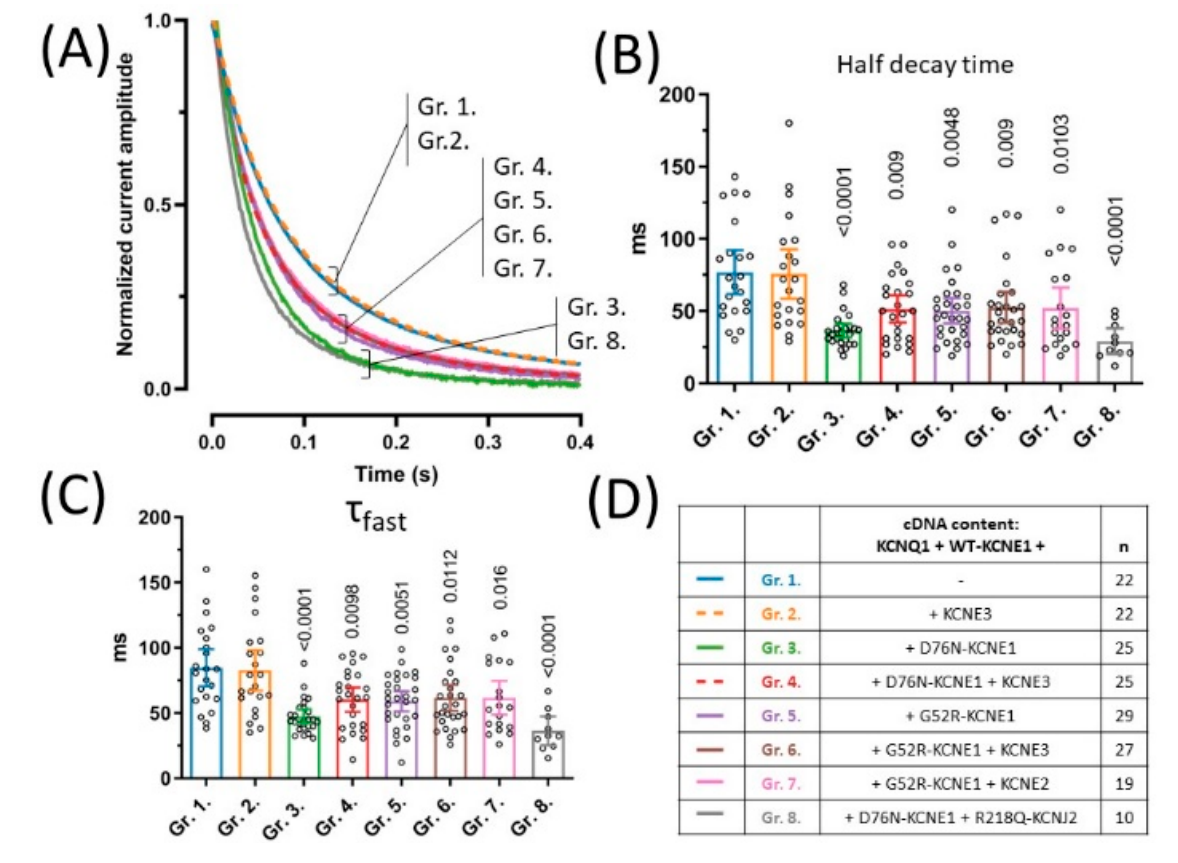
Figure 2. Deactivation kinetics were assessed by characterizing the kinetics of current decay of tail currents observed at − 40 mV following a 5 s long activating pulse from − 80 mV to 50 mV ( A ). Half decay times of tail currents were defined as time from tail current peak to 50% decay ( B ), whereas time constant of the fast exponential component were extracted from non-linear curve fits of tail current traces ( C ). Symbols represent individual data points; bar graphs represent mean ± 95% CI. Group means were statistically compared to that of Group 2. by one-way ANOVA followed by Holm–Sidak’s post-hoc tests. Multiplicity-adjusted p values are shown where difference between group means was considered significant ( p < 0.05). cDNA content of transfections are indicated in ( D ), where ‘n’ means number of experiments.